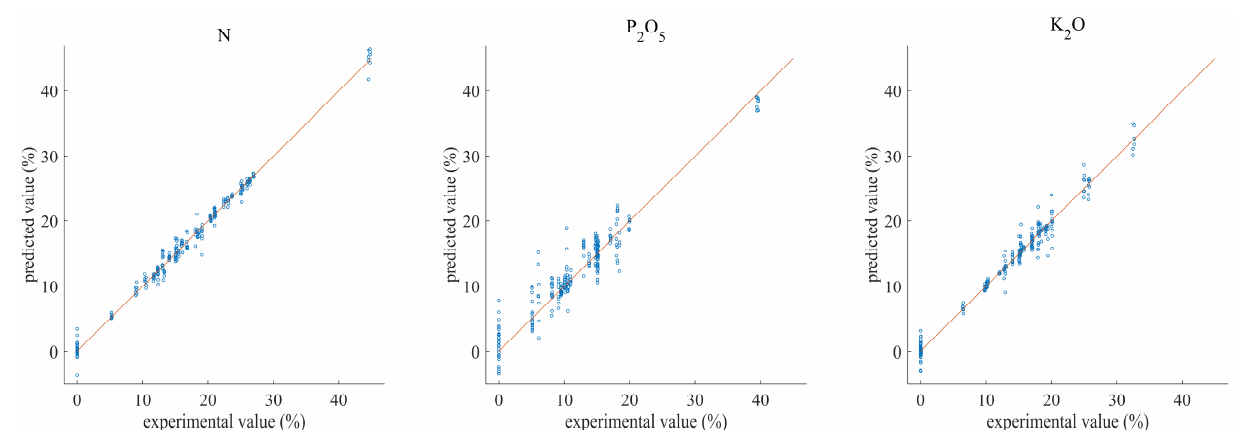
Figure 5. Scatter plot of the experimental value and predicted value.